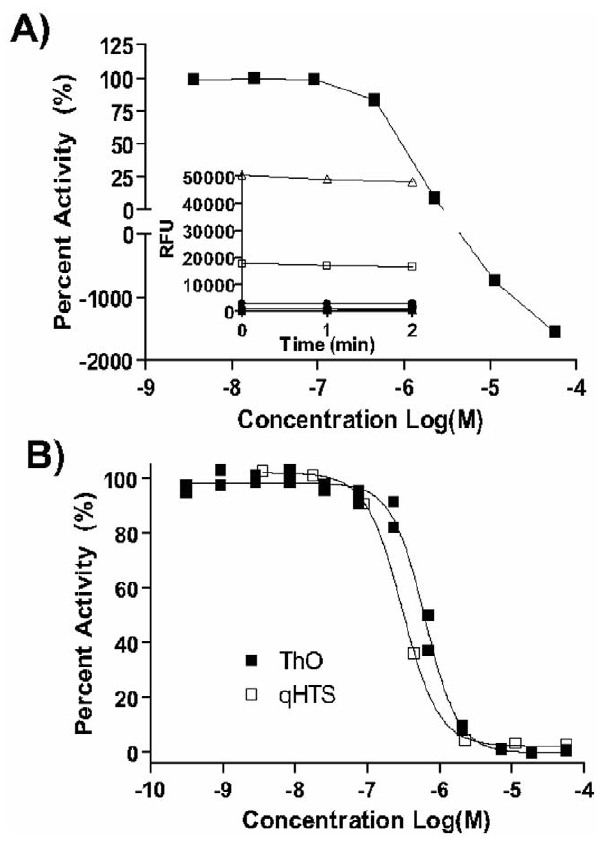
Figure 4. Elimination of assay artifacts and promiscuous hits. A) An autofluorescent compound contributes fluorescence intensity well in excess of the assay reaction’s average leading to the computation of aberrant concentration response curve. B) An example of a promiscu- ous hit acting by strong DNA binding as evidenced by the highly similar concentration responses observed in the primary screen (empty squares) and the ThO counterscreen (filled squares).